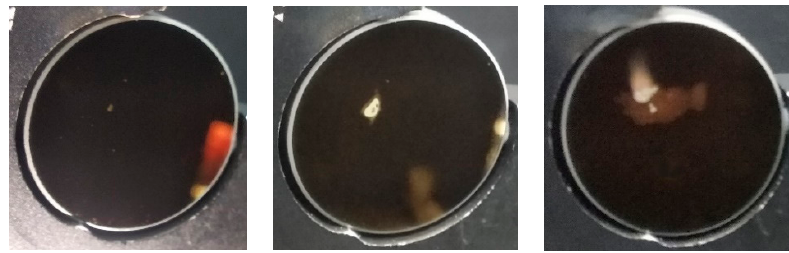
Figure 5. Damage phenomenon of the Ge window with long-pulse laser irradiation .